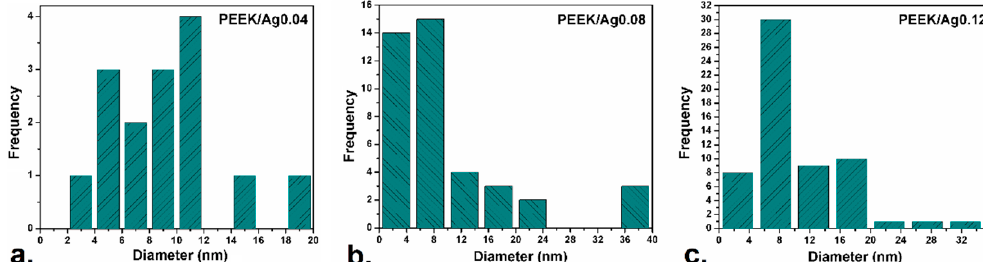
Figure 4. Distribution of the particle sizes determined from the TEM data at 50 nm of the obtained samples with 2 layers. ( a ) PEEK/Ag0.04, ( b ) PEEK/Ag0.08 and ( c ) PEEK/Ag0.12